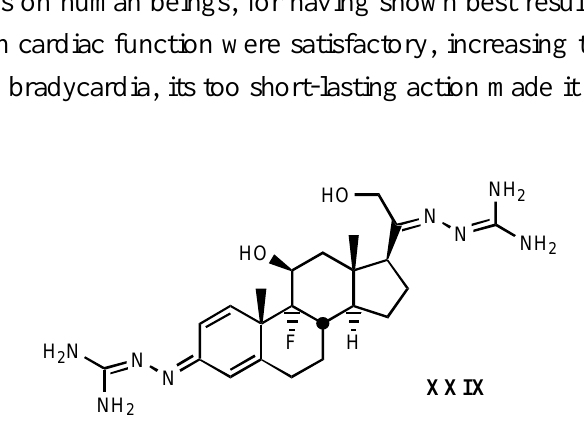
Figure 26. Structure of 3,10-bisguanylhydrazone of triamcinolone ( XXIX